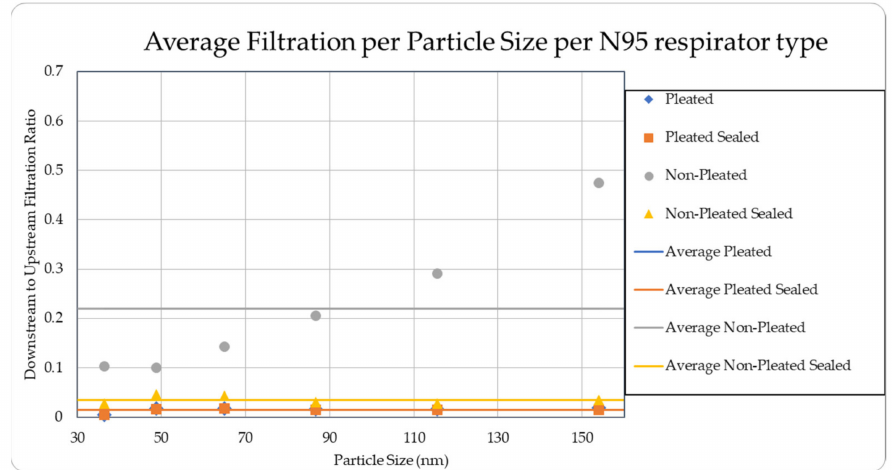
Figure 12. Average filtration ratios per particle size at the Carruth Welding